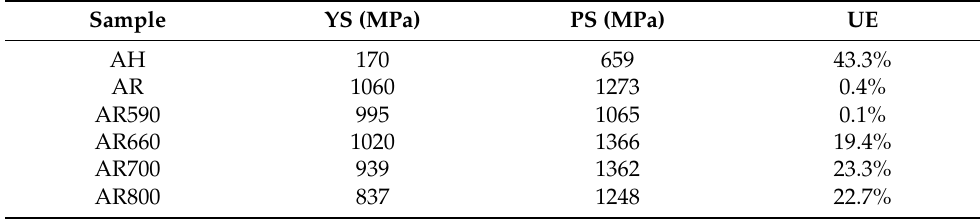
Figure 9. ( a ) Engineering stress vs. engineering strain curves and ( b ) true stress vs. true strain curves of various samples. Table 5. Yield strength (YS), peak strength (PS) and uniform elongation (UE) of various